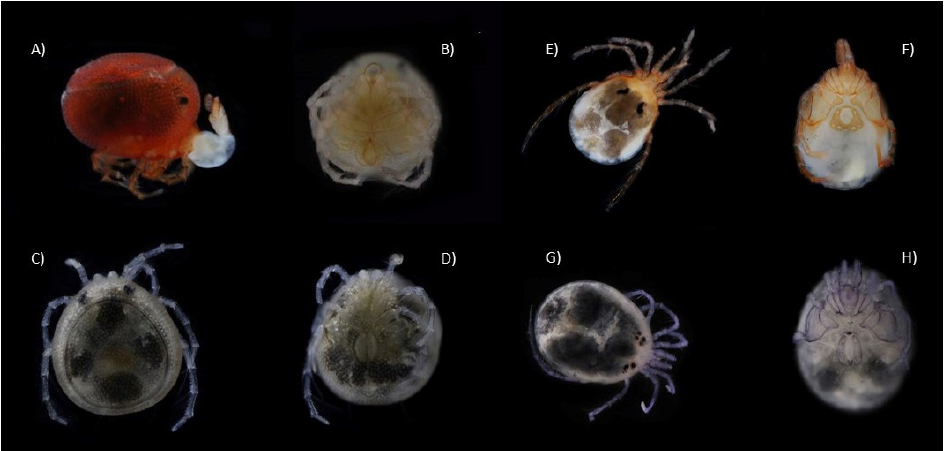
Figure 3. Members of Krendowskiidae family and Limnesia genus. ( A , B ) Lateral and ventral view of Geayia BIN ACT6195; ( C , D ) Dorsal and ventral view of Krendowskia BIN ACX8435; ( E , F ) dorsal and ventral view of Limnesia BIN ACY7380; and ( G , H ) dorsal and ventral view of Limnesia BIN AEA5595.